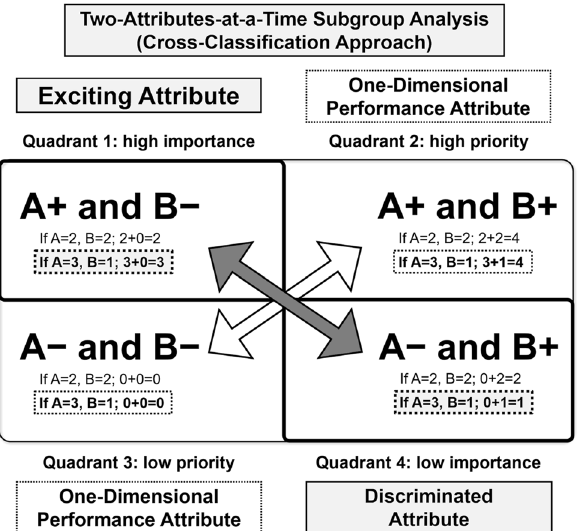
Figure 1. Cross-classification approach for attributes (importance grid analysis). Cross-classification of the attributes showing which attribute, A or B, is important. First, Quadrants 2 and 3, which are diagonal elements, generally become one-dimensional performance attributes with a high value in Quadrant 2 and low value in Quadrant 3. Quadrants 1 and 4, which are off-diagonal elements, can be used to discriminate the importance of A and B. When the attribute value of A is higher than that of B, Quadrant 1 becomes an exciting attribute. For example, if the attribute value of A is 3 and that of B is 1, the attribute value of A positive and B negative is 3, which is higher than Quadrant 4 (A negative and B positive, which has an attribute value of 1). Therefore, by considering differences between Quadrants 1 and 4, the difference in the importance of A and B can be found. A+, A positive; A−, A negative; B+, B positive; B−, B